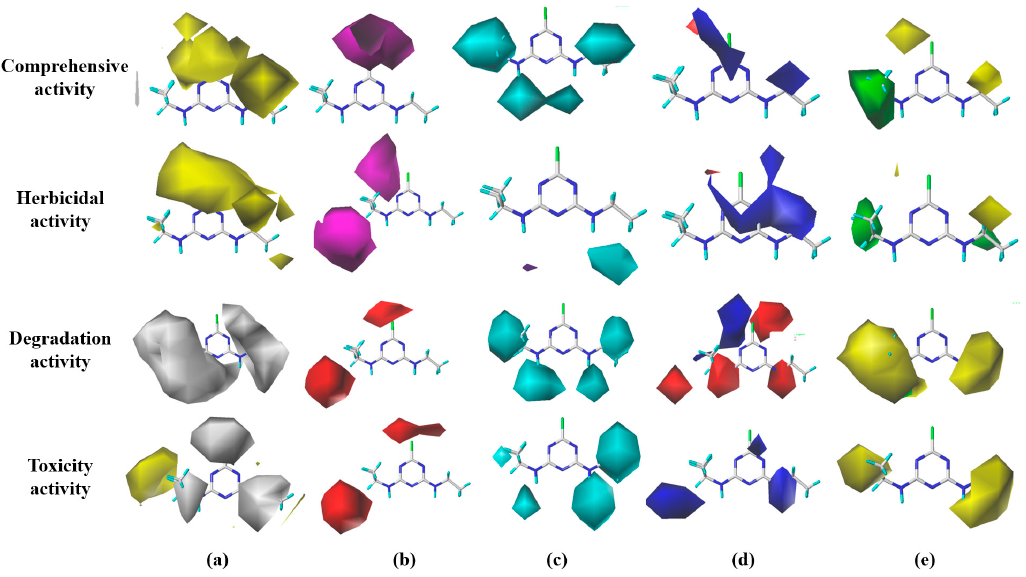
Figure 1. The 3D isopotential diagrams of the single-effect and comprehensive-effect CoMSIA models of herbicidal functionality properties, degradability, and toxicity of S-THs: ( a ) hydrophobic field; ( b ) hydrogen-bonded acceptor field; ( c ) hydrogen-bonded donor field; ( d ) electrostatic field, and ( e ) steric